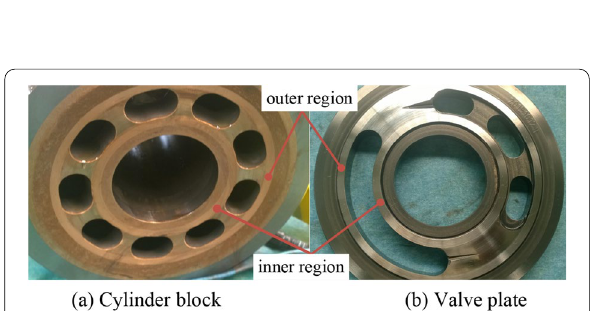
Figure 20 Friction and wear characteristics of valve plate/cylinder block in a real piston